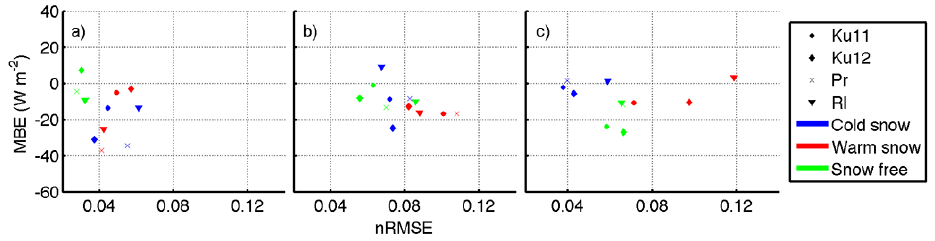
Figure 9. Model performance for (a) Q ∗ , (b) Q H and (c) Q E during the cold snow, warm snow and snow-free periods. Mean bias error (MBE) versus normalized root means square error (nRMSE) for different sites and for Ku separately (years 2011 (Ku11)) and 2012(Ku12)). Table 5. Model evaluation statistics based on performance relative to observations of net all-wave radiation ( Q ∗ , Wm − 2 ) , sensible ( Q H ,Wm − 2 ) and latent heat fluxes ( Q E ,Wm − 2 ) undertaken for 2 years at one site in Helsinki (Ku11 for 2011 and Ku12 for 2012) and 1 year for two sites in Montreal (Pr and Rl). The statistics: RMSE is the root mean square error (Wm − 2 ) , nRMSE the normalized RMSE (Eq. 17), sRMSE (Eq. 18) is RMSE normalized with standard deviation of the observed value and N is the number of points in the linear fit. Cold snow Melting snow Snow-free RMSE nRMSE sRMSE N MBE RMSE nRMSE sRMSE N MBE RMSE nRMSE sRMSE N MBE Ku11